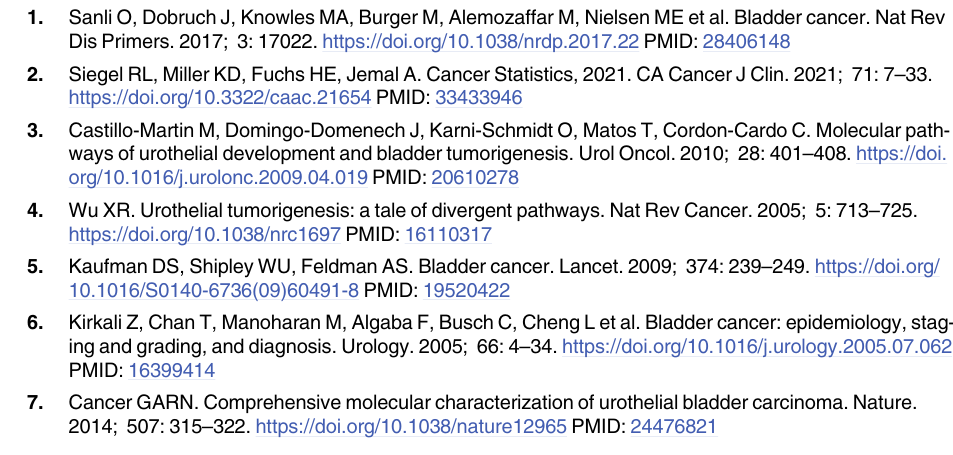
S2 Fig. The mutation of Spred2 in cancers. Data were from TCGA Pancancer Atlas from cBioPortal for Cancer Genomics (https://www.cbioportal.org/results/plots). (A) The Spred2 mutations in different cancer. Bladder cancer is the 3 rd place having mutation of Spred2 among cancers. (B) The distribution of mutations on the domain structure of Spred2 in blad- der urothelial